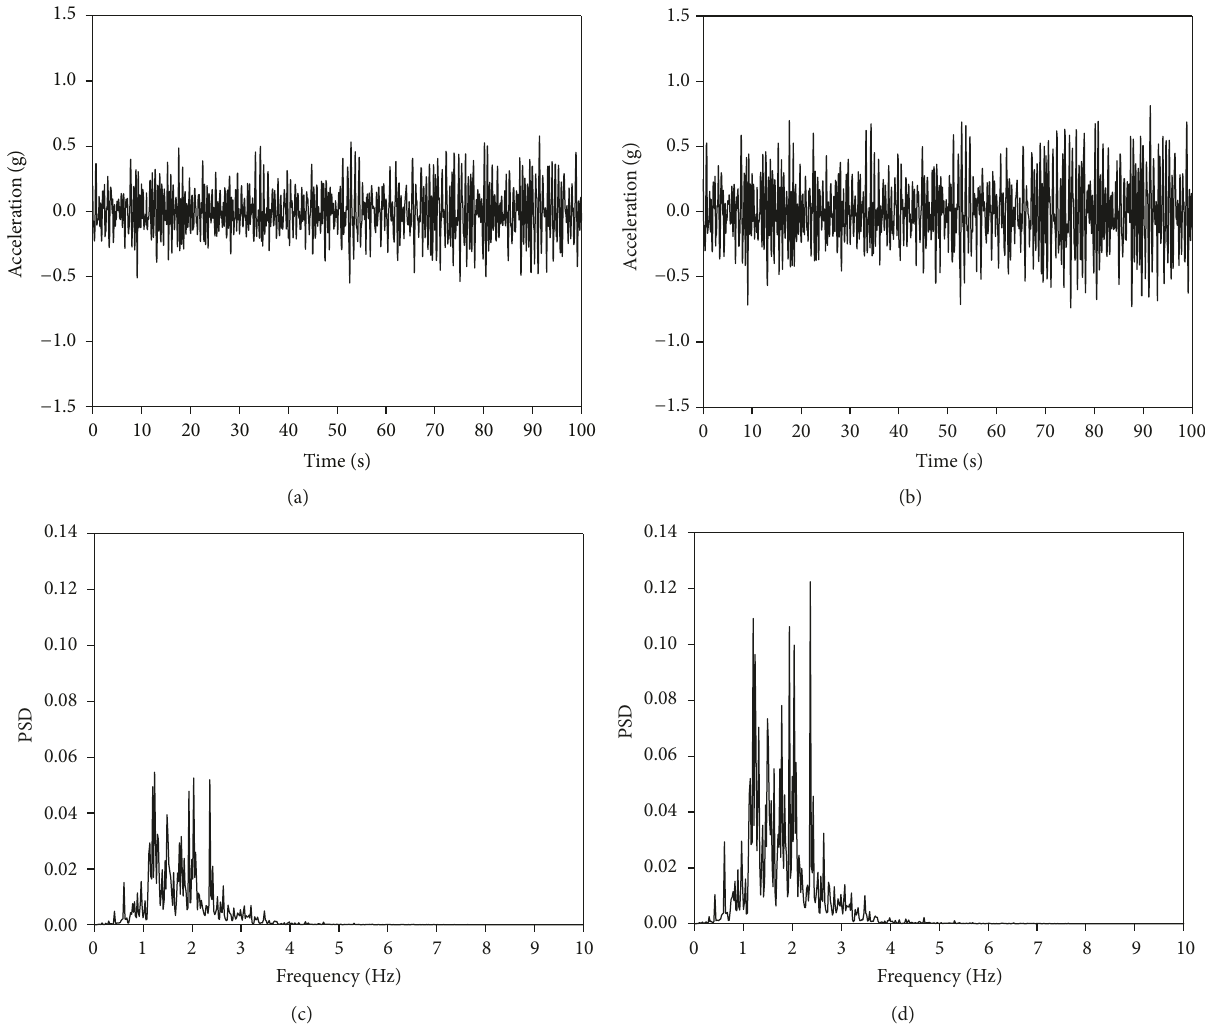
Figure 14: Acceleration results under 45 ∘ wind direction: (a) 𝑋 acceleration of point 1; (b) 𝑌 acceleration of point 3; (c) power spectral density of 𝑋 acceleration of point 1; (d) power spectral density of 𝑌 acceleration of point